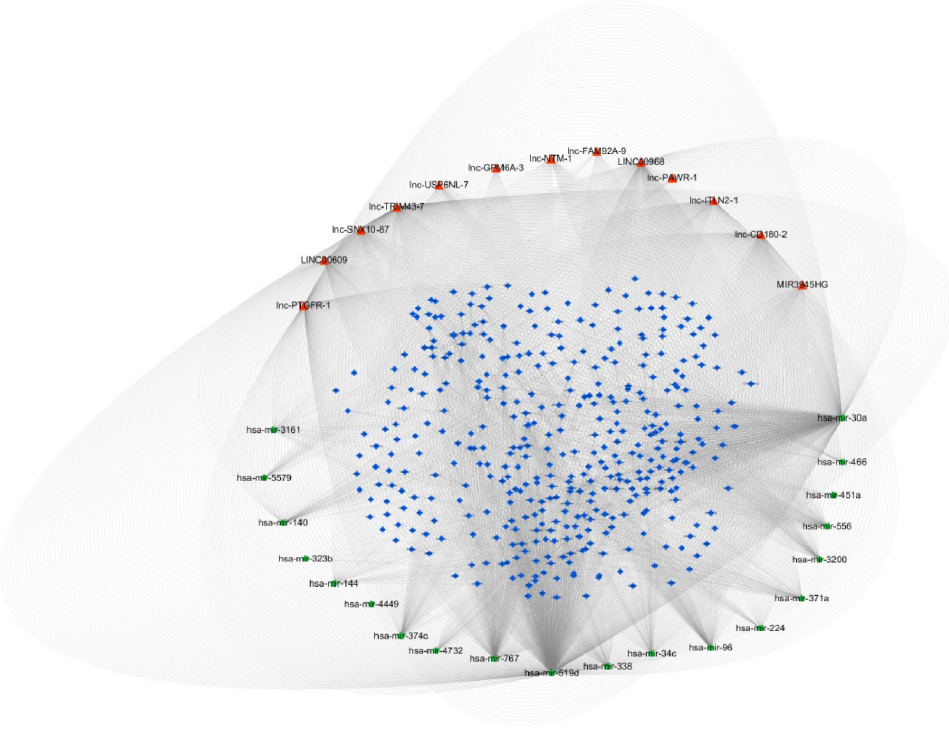
Fig 9. CeRNA ternary diagram of lncRNA-miRNA-mRNA. The red triangle represented lncRNA, the green dot represented miRNA, and the blue diamond represented mRNA. Significantly differentially expressed miRNA and lncRNA regulatory network, p <